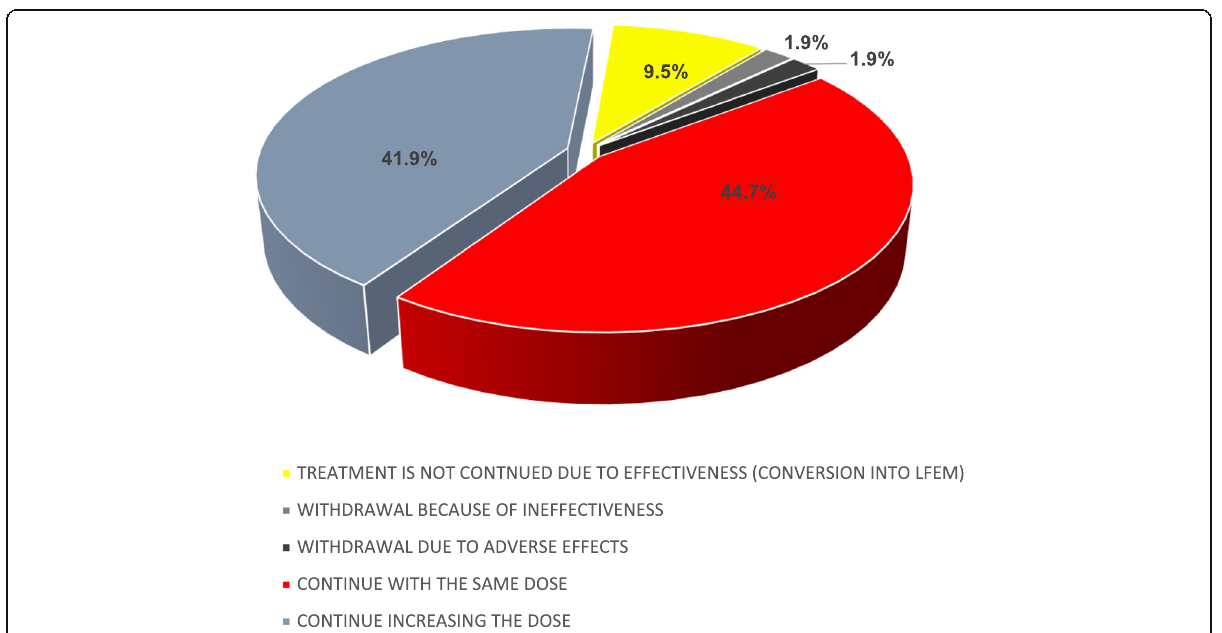
Fig. 1 Sector graph showing clustering of the 210 migraine patients according to erenumab response after 12 weeks of treatment